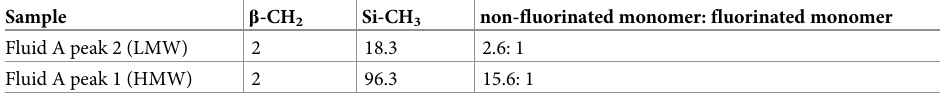
Values for samples HMW: high molecular weight and LMW: low molecular weight. 1 HNMR β -CH 2 integral was set to the value 2. 1 HNMR data is representative of several